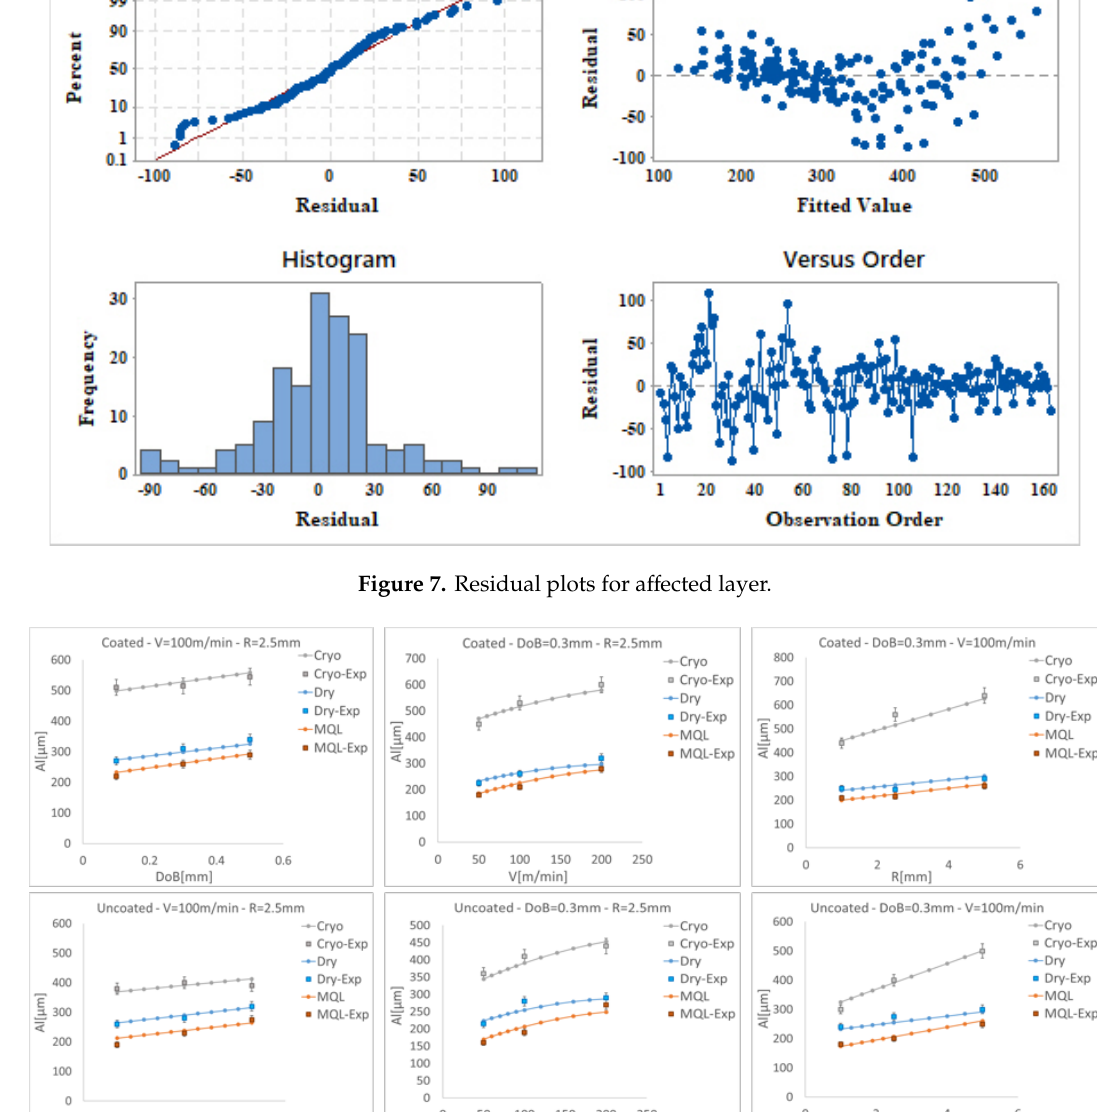
Table 5. Values for force constants in varying lubro/cooling and coating conditions.